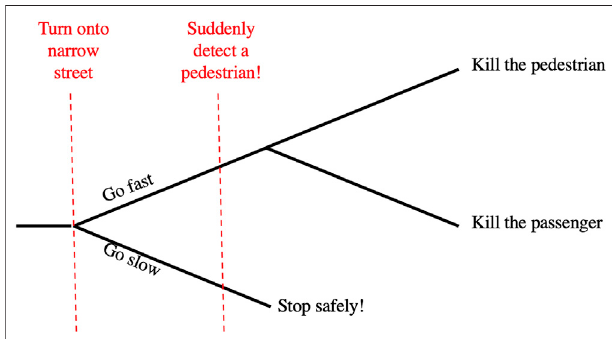
FIGURE 5 | Identify an upstream decision point to avoid the Deadly